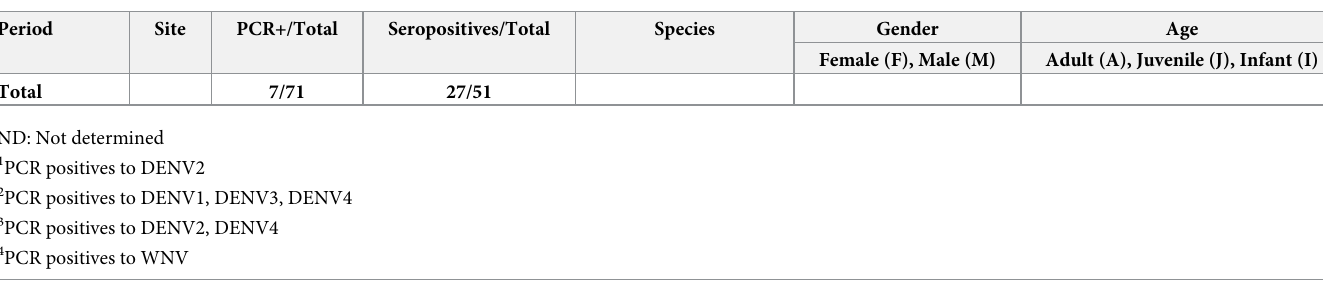
(Qiagen, Hilden) according to the manufacturer’s instructions. The RT-PCR was carried out for DENV (DENV1 to DENV4) and WNV as described previously using highly specific prim- ers and sensitive conditions [23, 24]. Briefly, the conventional semi-nested protocol for sero- typing DENV as described by Lanciotti et al. [23], that amplifies a segment of C-prM region was used. For detection of WNV the RNA was subjected to a RT-PCR as described by Lanciotti et al. [24] that amplifies a region of the WNV envelope gene. The DENV-positive controls